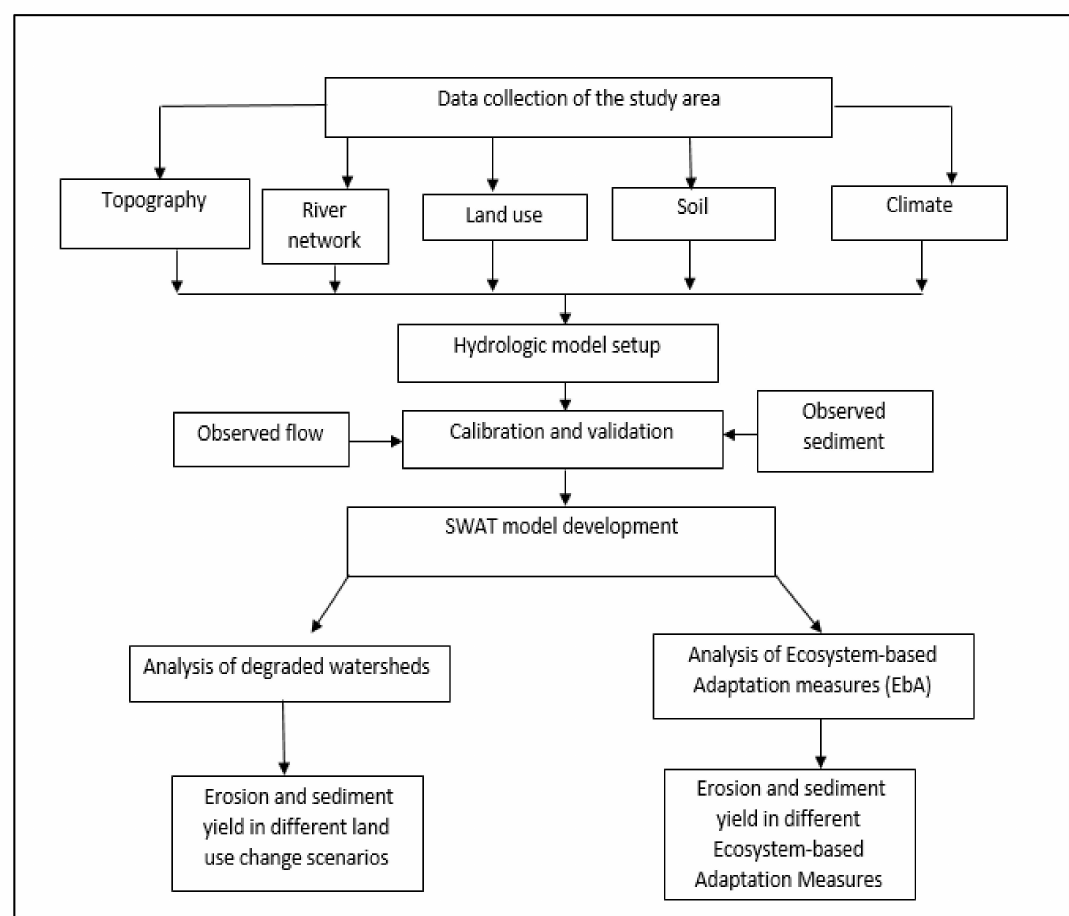
Figure 1. The framework of the